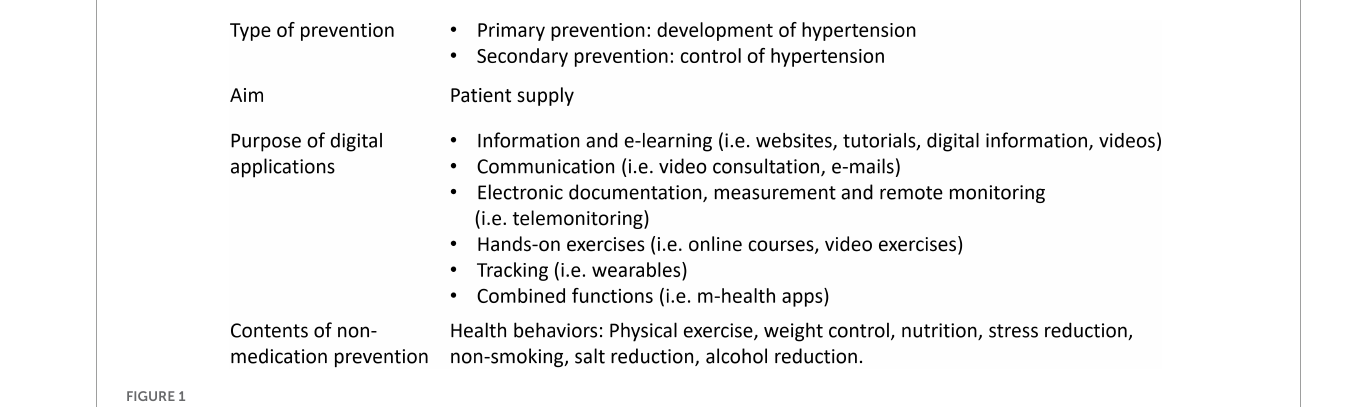
FIGURE1 Characteristics of digital preventive measures for arterial